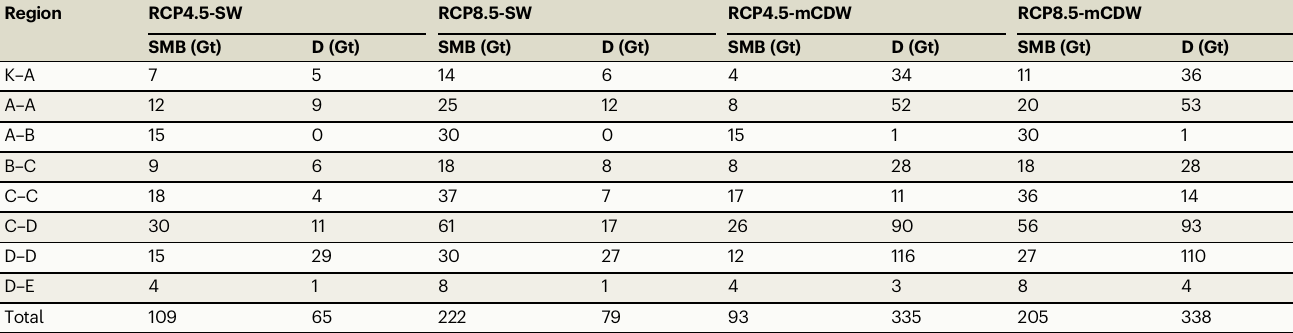
Table 3 | Surface mass balance and ice discharge for the four climate forcing scenarios after 200 years of simulation time Region